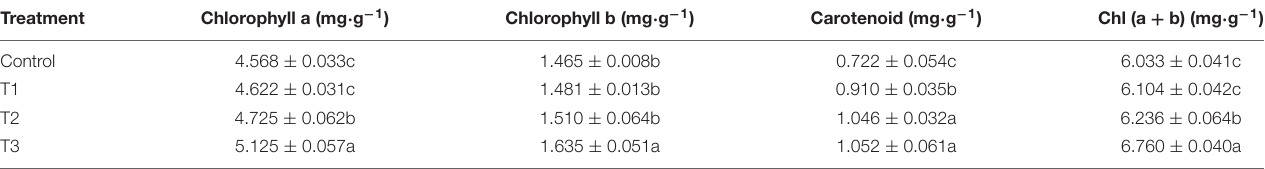
TABLE 3 | Effects of supplemental LED light duration on photosynthetic pigment.